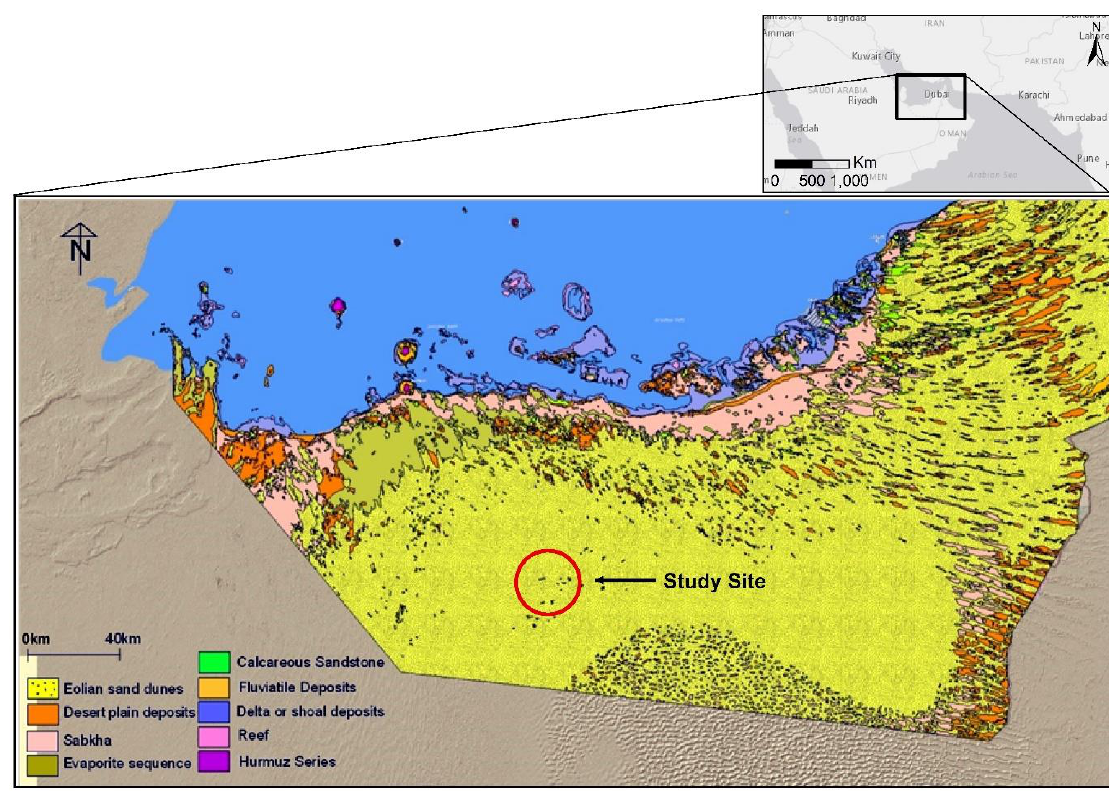
Figure 1. Location and geological map of the study area. Geological map adapted from https://enviroportal.ead.ae/map/.